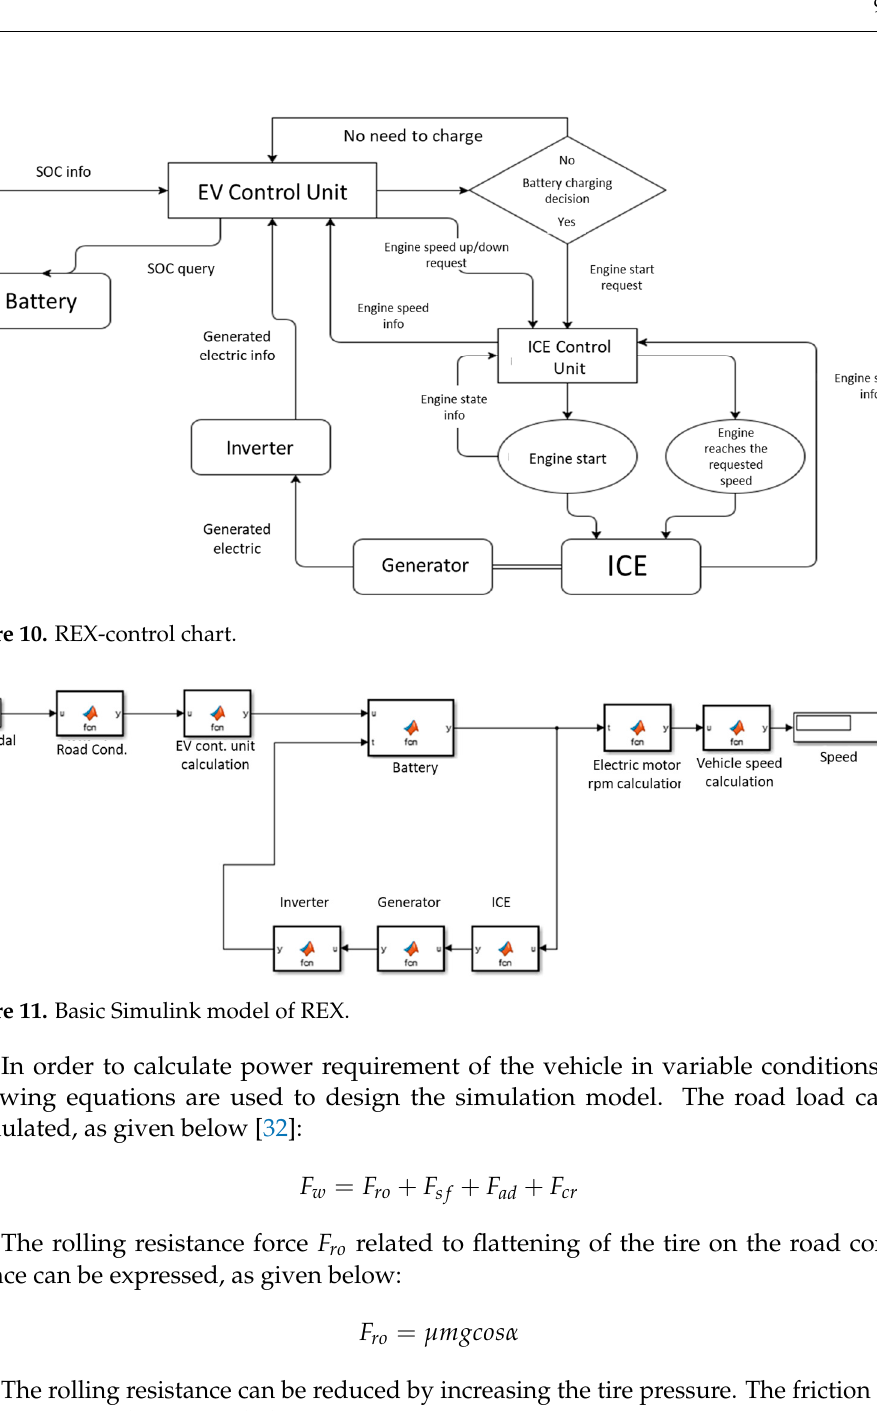
Figure 11. Basic Simulink model of REX.